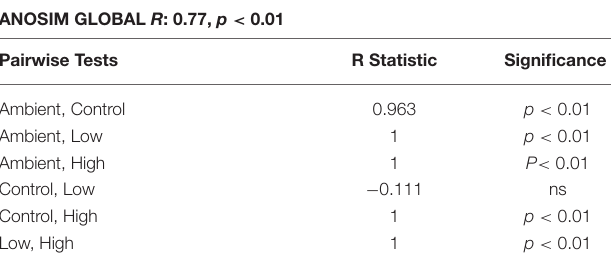
bottom right side of the plot, the High treatment samples are grouped together. ANOSIM results ( Table 1 ) indicate that there are significant differences between samples (Global R: 0.77, p <